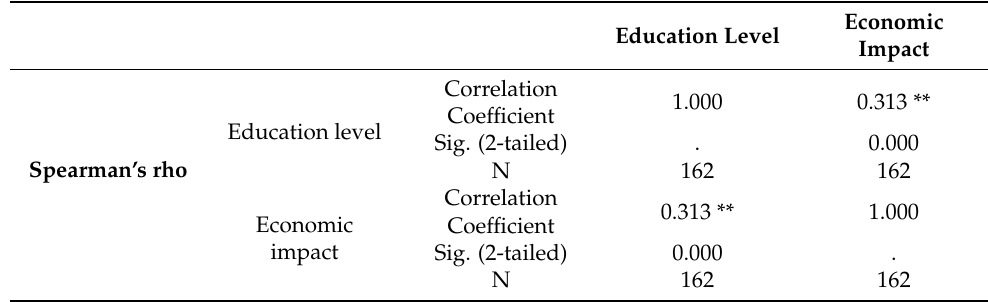
Table 7. Spearman’s rank correlation coefficient between farmers’ education level and farms’ eco- nomic impact.